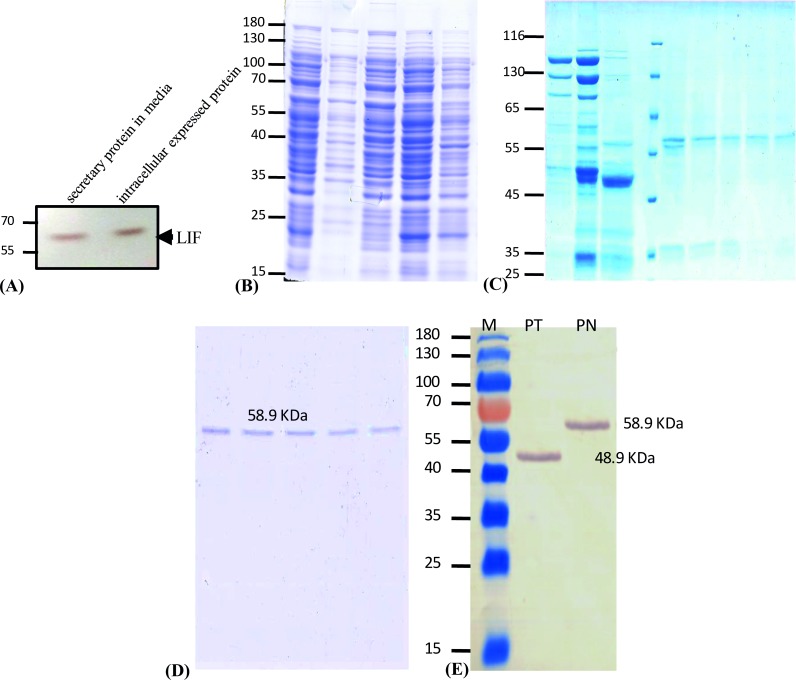
Expression of LIF in COS-1 cells.(A) GFP-tagged full-length LIF was expressed in COS-1 cells and detected by western blot as a secretory protein in the media as well as in total cell lysate. (B) SDS-PAGE Profile: Gel showing the initial washing fractions of the rBuLIF protein during affinity purification of whole cell lysate from the first run of purification. (C) Initially, collected fractions during the chromatographic run from Lane 1, 2 and 3 all the proteins obtained were concentrated in a lyophilizer 1:20 folds to visualize clearly in the SDS gel. M lane for the marker, first run elution profile of the peak shown in the Fig 2A-lanes 4–8. (D) The second run of the chromatographic elution: Eluted fractions from the first run were subjected to the same packed column for the separation of the proteins, based on the affinity. (E) Western blot image of purified rBuLIF protein for confirmation. M lane for the marker, PT lane for PNGase F treated BuLIF without glycan moieties showing 10 kDa reduction in size, PN lane for non-PNGase treated showing intact purified rBuLIF protein of 58.9 kDa molecular weight.